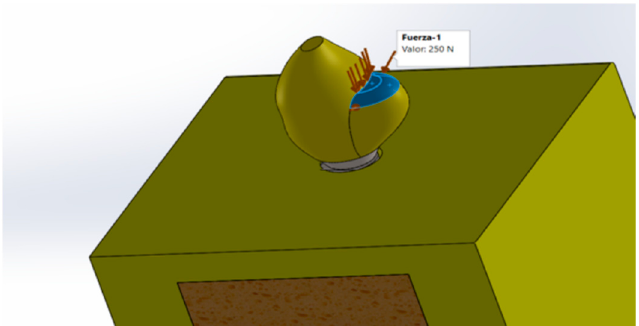
Figure 2. Application of forces at the occlusal side (palatal cuspid). All materials were considered to be isotropic, homogeneous, and nonlinear. Consid- ering the physical properties of each material (Table 1), the maximum and minimum von Mises stress values were determined for each model. The von Mises analysis showed a color scale, which allowed us to visualize, in red, the areas of greatest stress. The models were labeled according to the implant–abutment connection system (i.e., EH, IH, MT, CC, and